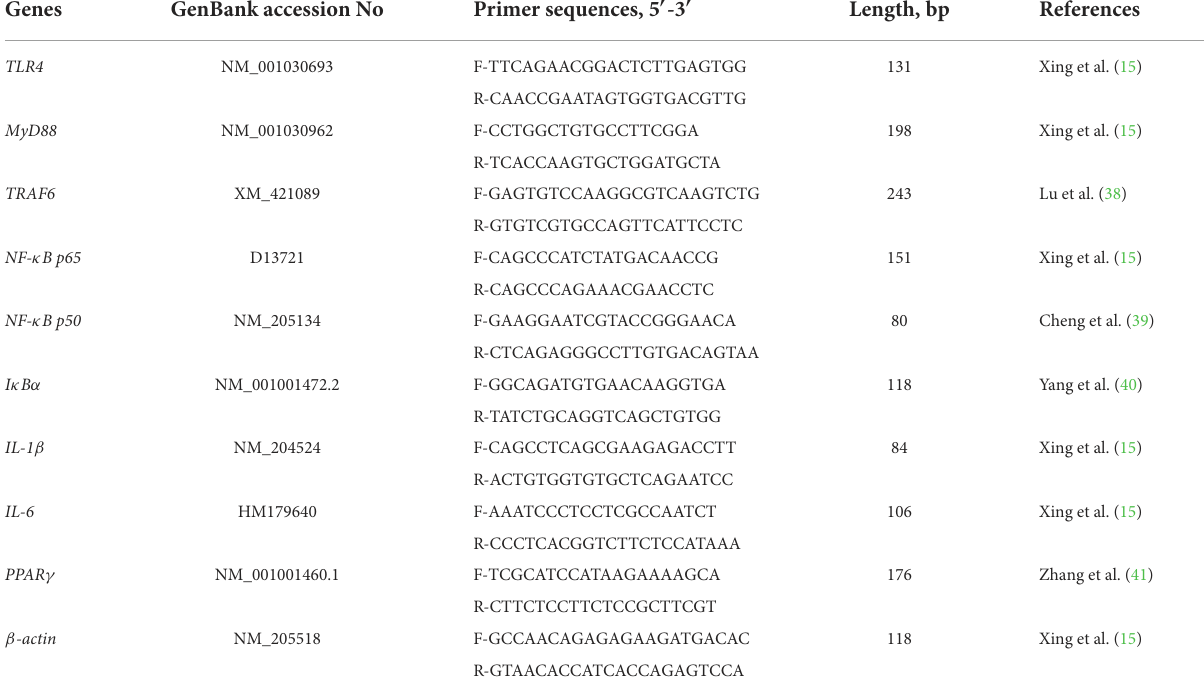
TABLE 2 Primer sequences and parameter.